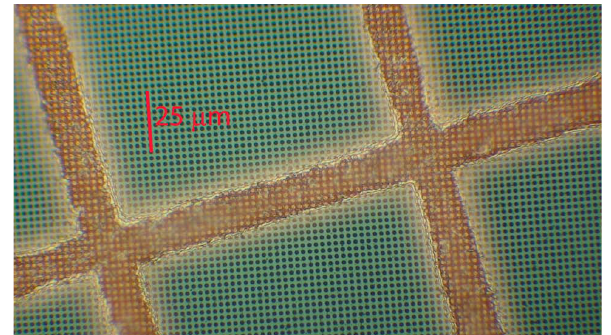
Figure 2. Fig. 2. A Quantifoil substrate imaged with the optical microscope. The legend covers 10 holes or 25µm. The fine mesh pitch is 2.5µm.